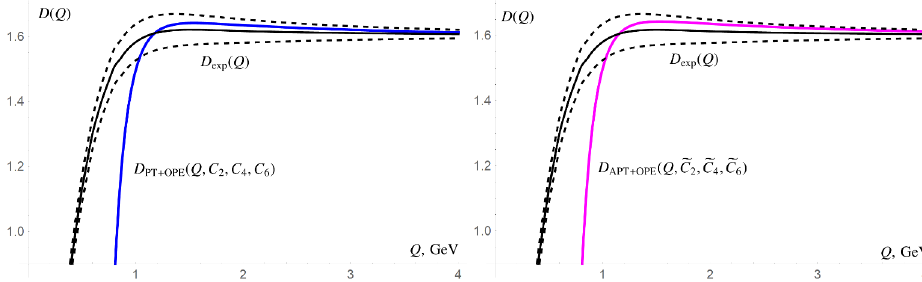
Figure 3. The standard dependence of D -function on Q for PT (left panel) with received values of C 2 and C 4 (blue) and for APT (right panel) with (cid:101) C 2 and (cid:101) C 4 (magenta) and dispersion curves (black) with taking into account dominant systematic error (statistic error is negligible)